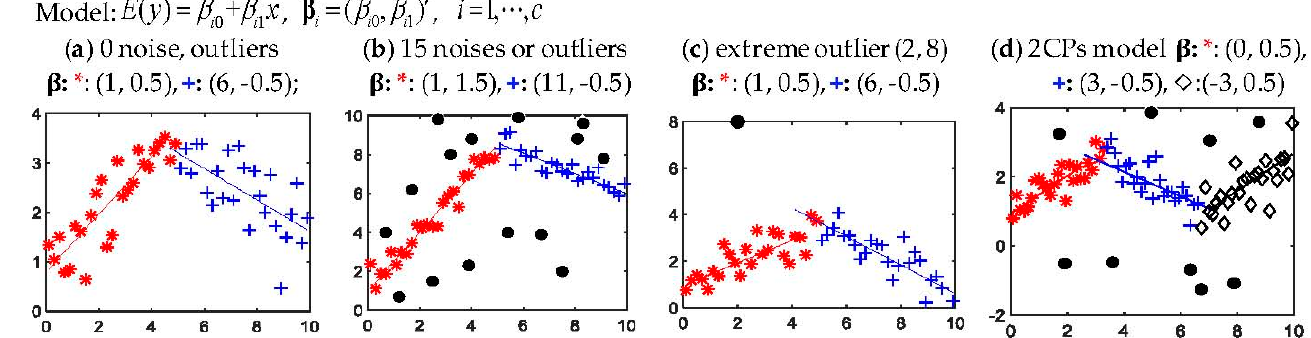
Figure 1. Models used to show EMT1 performs better, β : * : (1, 0.5), + : (6, − 0.5) show the coefficients of the model from which data were generated; here, β : *: (1, 0.5), + : (6, − 0.5) indicate that the data marked * and + in the figure were generated from models E ( y ) = 1 + 0.5 x and E ( y ) = 6 − 0.5 x , respectively. These notations are also used for the figures Table 1. The performance of EMT and FCT with different degrees of freedom.